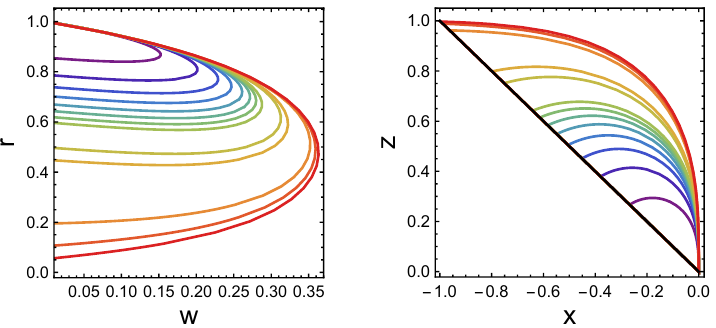
Figure 7 . The RT surfaces in coordinates ( t, r, w, y ) and ( t, z, x, y ) for different λ in 4 -dimensional black hole, where { d, θ, x = { 3 , π/ 4 , 0 } and λ = 0 . 3 , 0 . 4 , 0 . 5 , 0 . 6 , 0 . 7 , 0 . 8 , 0 . 9 , 1 , 1 . 6 , 2 , 7 , 14 , 28 (from b } the UV region in violet to the IR region in red).